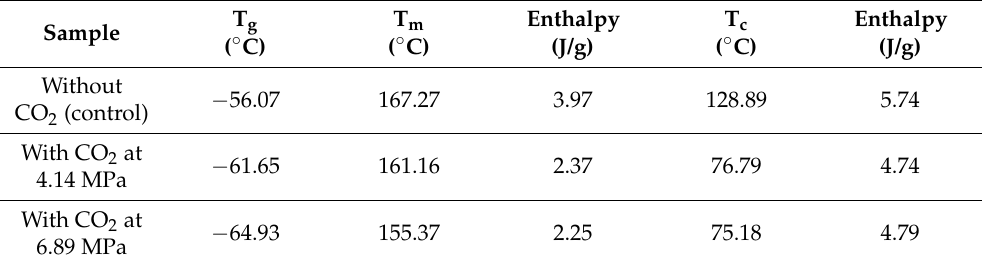
Table 5. DSC summary results at different scenarios.